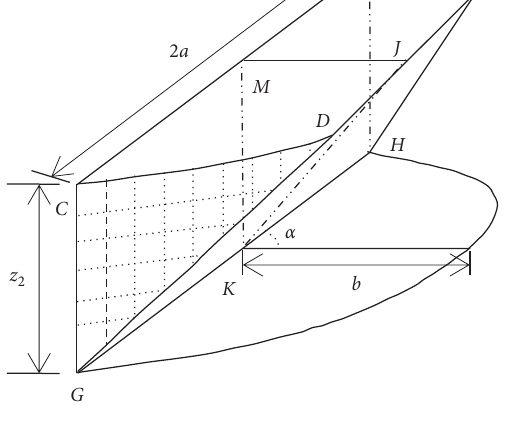
Figure 3: Local instability failure model.